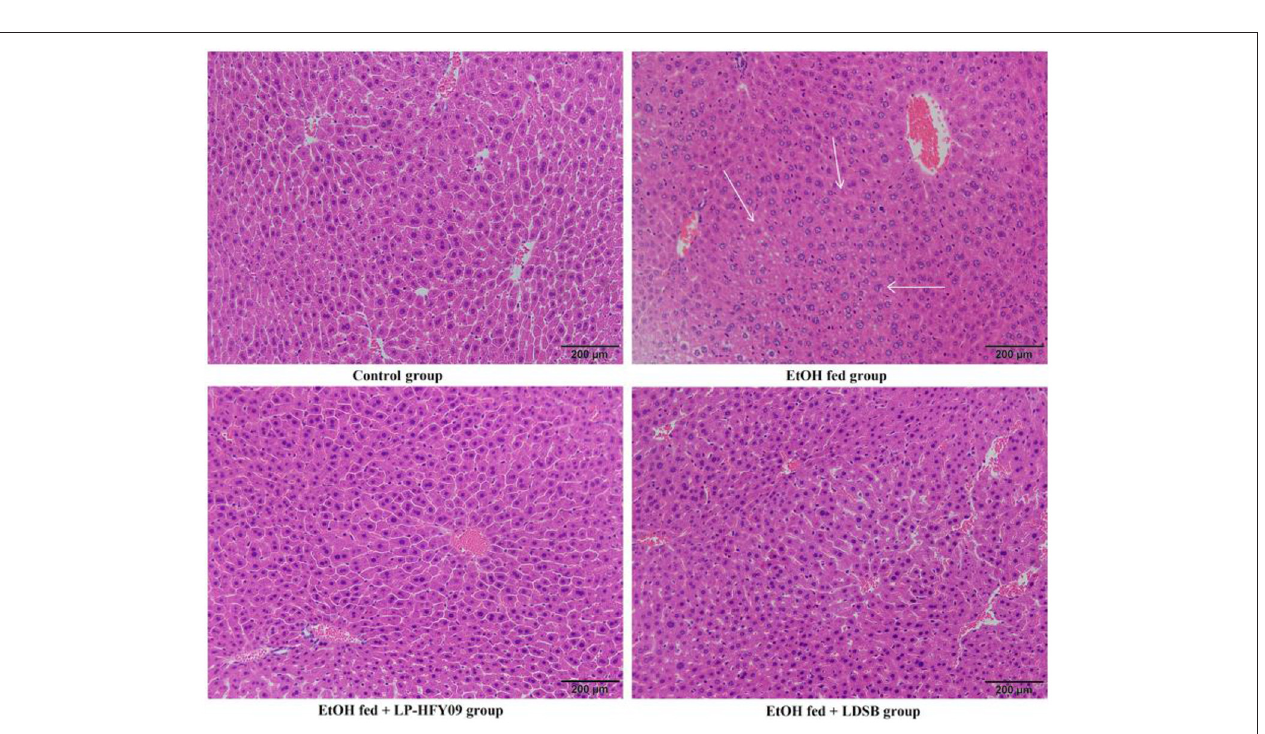
Serum Levels of ALT, AST, HAase, PC III, and Cytokine Indicators The serum levels of ALT, AST, HAase, PC III, TNF- α , IL-1 β , and IL-6 were significantly elevated, and IL-10 was significantly decreased by ethanol when compared to the control group ( p < 0.05; Table 2 ). When compared with the EtOH fed group, administration of LDSB and LP-HFY09 significantly decreased the levels of ALT, AST, HAase, PC III, and cytokine indicators (TNF- α , IL-1 β , and IL-6), and noticeably increased that of